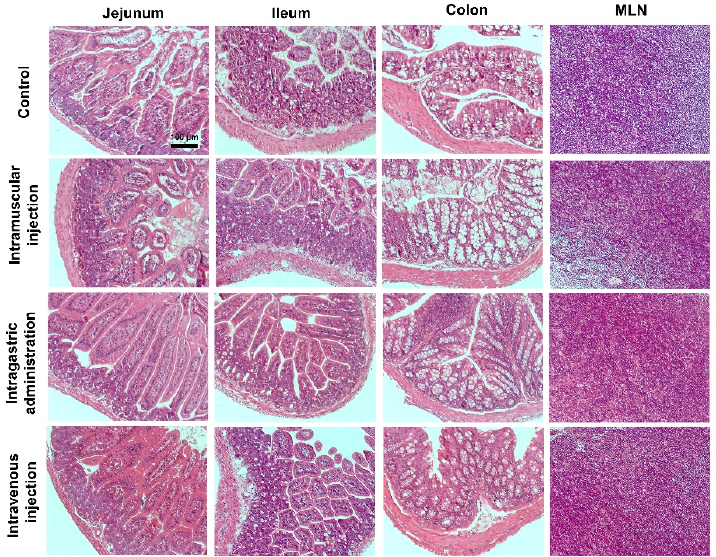
Figure 3. Histological examination of the jejunum, ileum, colon, and mesenteric lymph nodes (MLN) from the BALB/c mice exposed to intramuscular injection, oral administration, and intravenous injection at 7 days. Scale bar: 100 μ m.